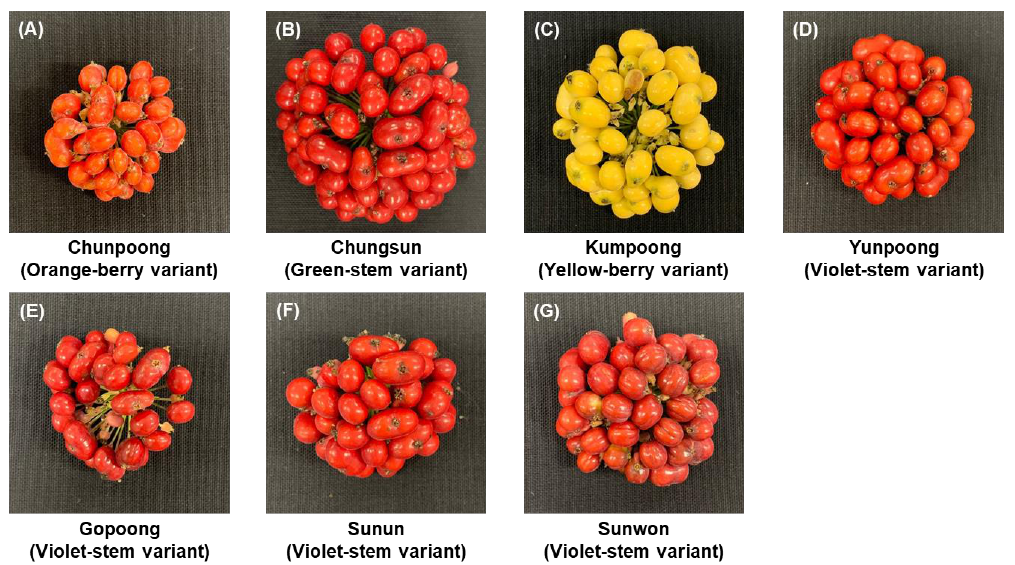
Figure 1. Characteristics of the fruit of varieties of ginseng. ( A ) Chunpoong. The color of the berries is orange. ( B ) Chungsun. The color of the berries is red. ( C ) Kumpoong. The color of the berries is yellow. ( D ) Yunpoong. The color of the berries is red. ( E ) Gopoong. The color of the berries is red. ( F ) Sunun. The color of the berries is red. ( G ) Sunwon. The color of the berries is red.